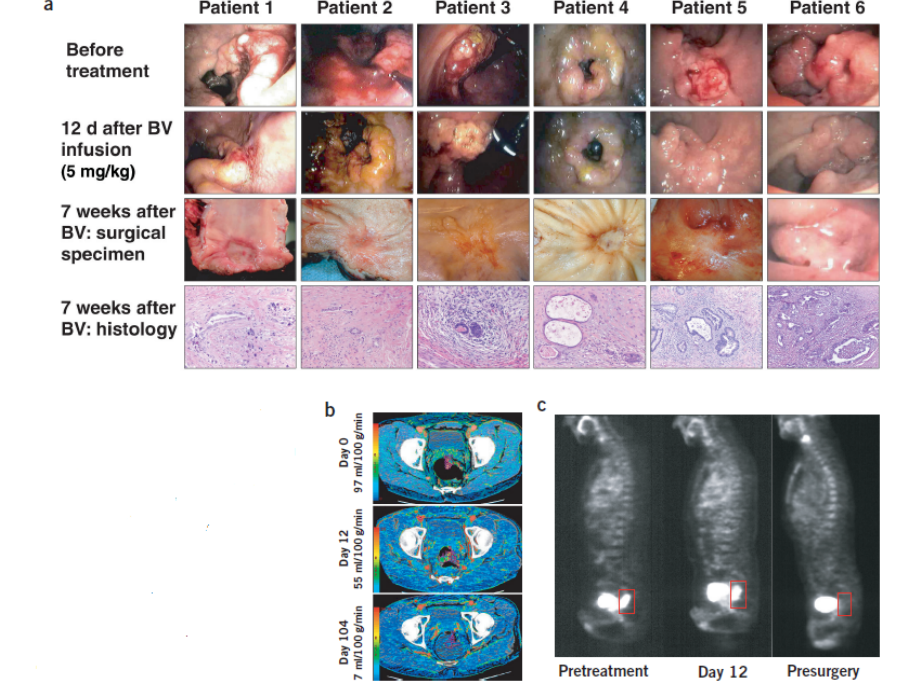
Figure 1. Effect of treatment on tumors in patients who completed entire combined treatment regimen, and surgery. ( a ) Endoscopic and pathological evaluation of rectal tumors. Surgical specimens showed grade II tumor regression in patients 1–5 and grade III in patients 6, by Mandard criteria. Endoscopic image (instead of surgical specimen) was taken for patients 6, 3.5 weeks before surgery. BV, bevacizumab. ( b ) Representative functional CT images of blood perfusion before treatment (day 0), after bevacizumab (day 12) and after completion of treatment (day 104) in patient 5. ( c ) Tumor FDG uptake before treatment (pretreatment), 12d after bevacizumab treatment and 6–7 weeks after completion of all neoadjuvant therapy (presurgery). Saggital projections of FDG-PET scans for patient 1 are shown. Tumor is outlined in box, posterior to the bladder. Reprinted with permission from Macmillan Publishers Ltd: Nature Medicine, Willet et al .